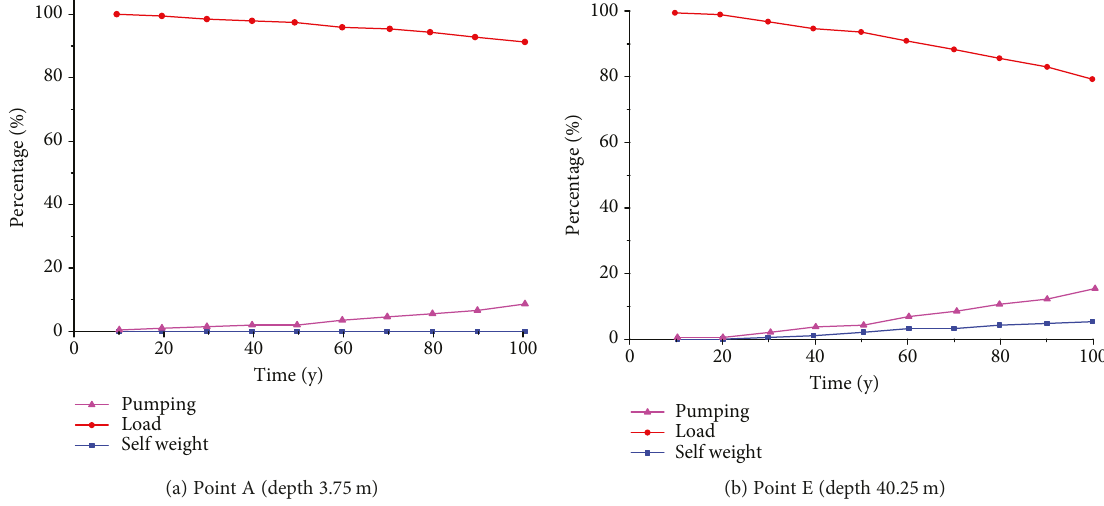
Figure 19: Percentage of settlement caused by di ff erent reasons when loading intensity is 500